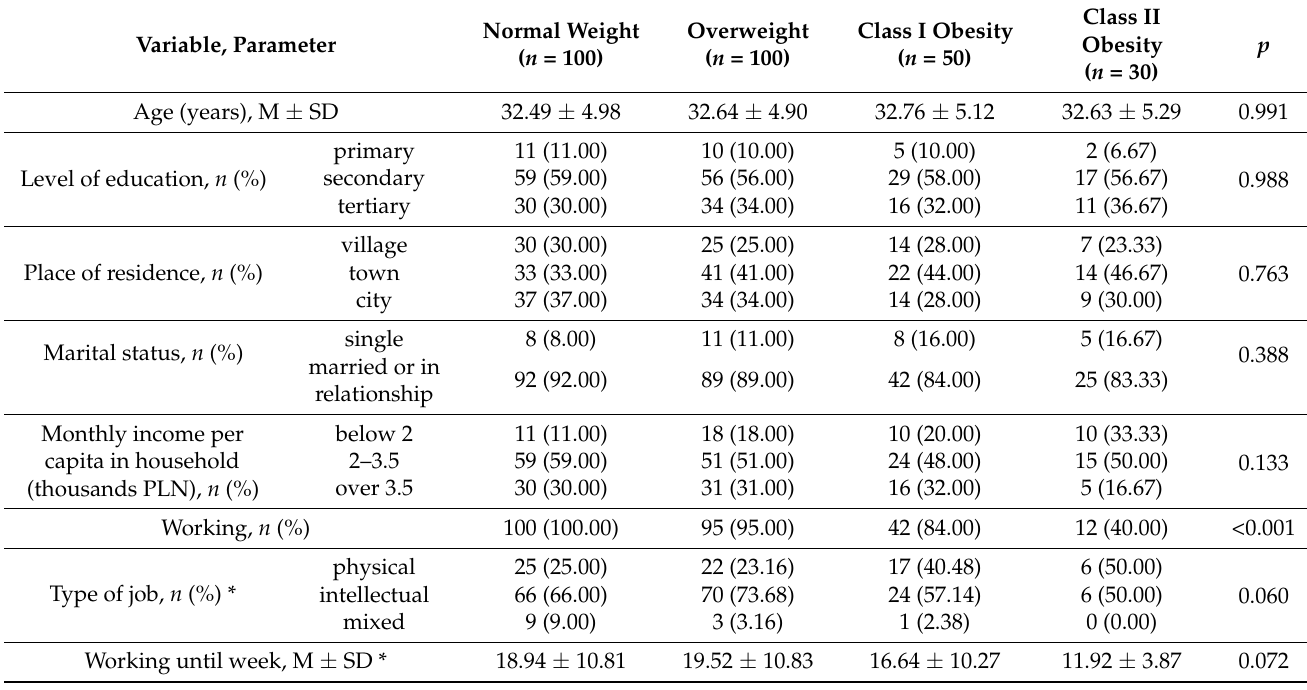
Table 1. Socio-economic characteristics of pre-pregnancy BMI groups.